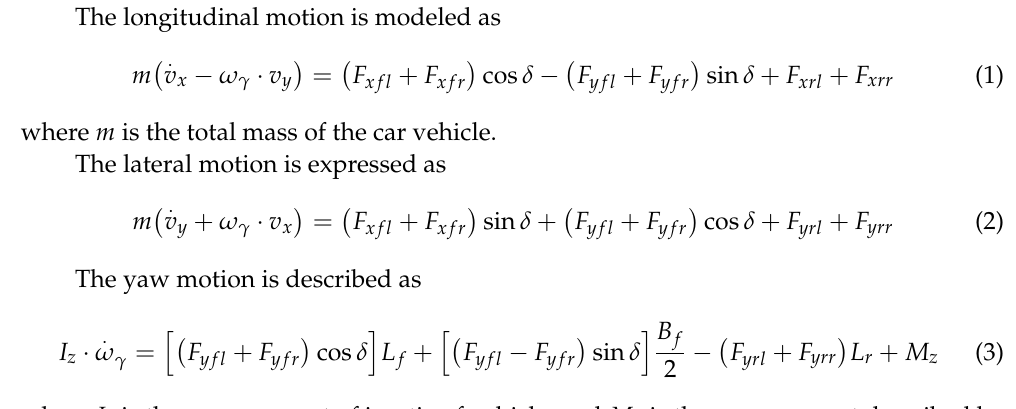
Figure 1. Schematic diagram of 7DOF vehicle model.